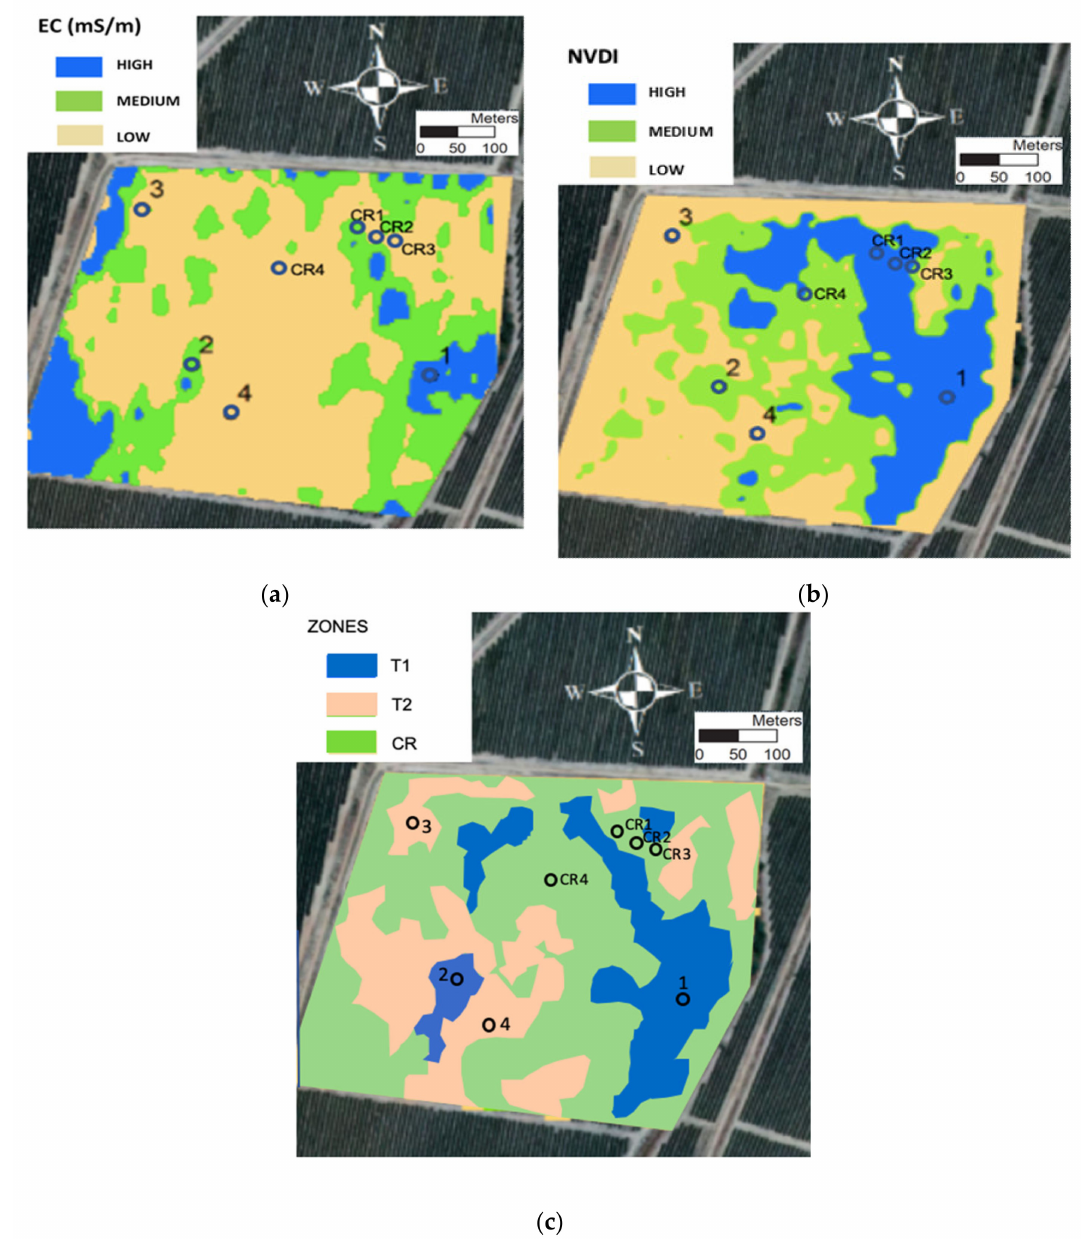
Figure 1. ( a ) Map of soil apparent electrical conductivity (EC) measured with a Dualem-1S sensor. High EC values are between 15–20 (mS / m), medium values between 10–15 (mS / m) and low values between 5–10 (mS / m); ( b ) Normalized di ff erence vegetation index (NDVI) map using a satellite image obtained from Sentinel-2A. High NDVI values are between 0.45–0.50, medium values between 0.40–0.45 and low values between 0.35–0.40, and; ( c ) maps of the di ff erent zones established in the study area. Circles 1, 2, 3 and 4 indicate the locations of the sampling sites where irrigation was managed manually, and circles CR1, CR2, CR3 and CR4 sites where irrigation was applied